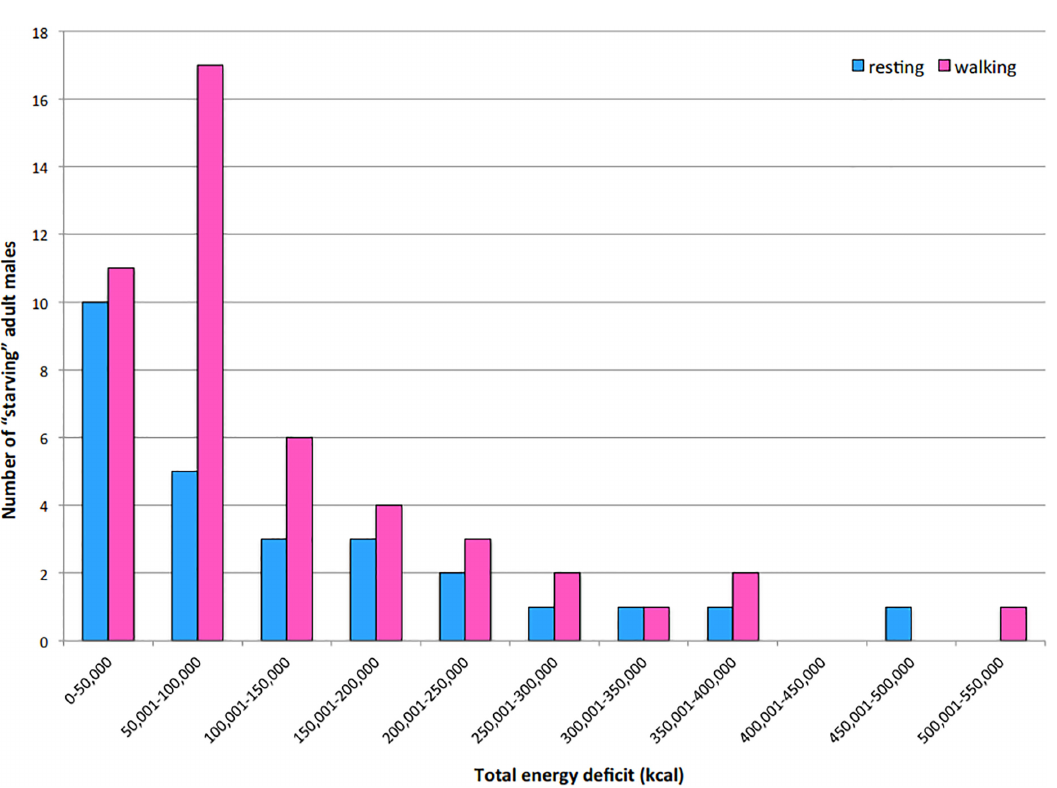
Fig 1. The number of starving adult males that are expected to come ashore with different-sized energy deficits during a 180-day ice-free season. Calculations are based on the additional kilocalories required for daily somatic maintenance and limited movement (2 km d -1 ) needed to prevent starvation in each bear for the entire projected 180 days